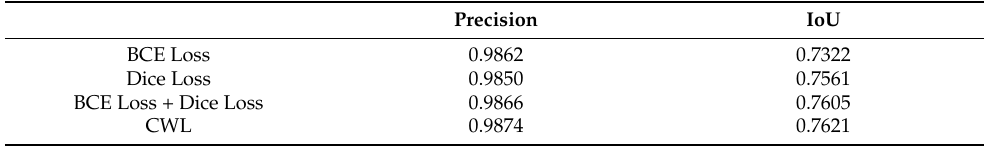
Table 1. Effect of different loss functions on road extraction